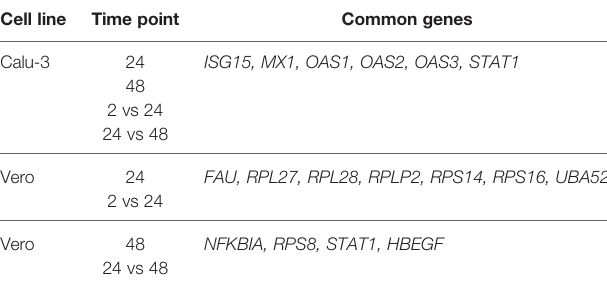
Calu-3 cells reveal expression level changes with genes related to innate immune responses, whereas Vero cells show expression level changes with ribosomal protein genes. Related to Figure S2